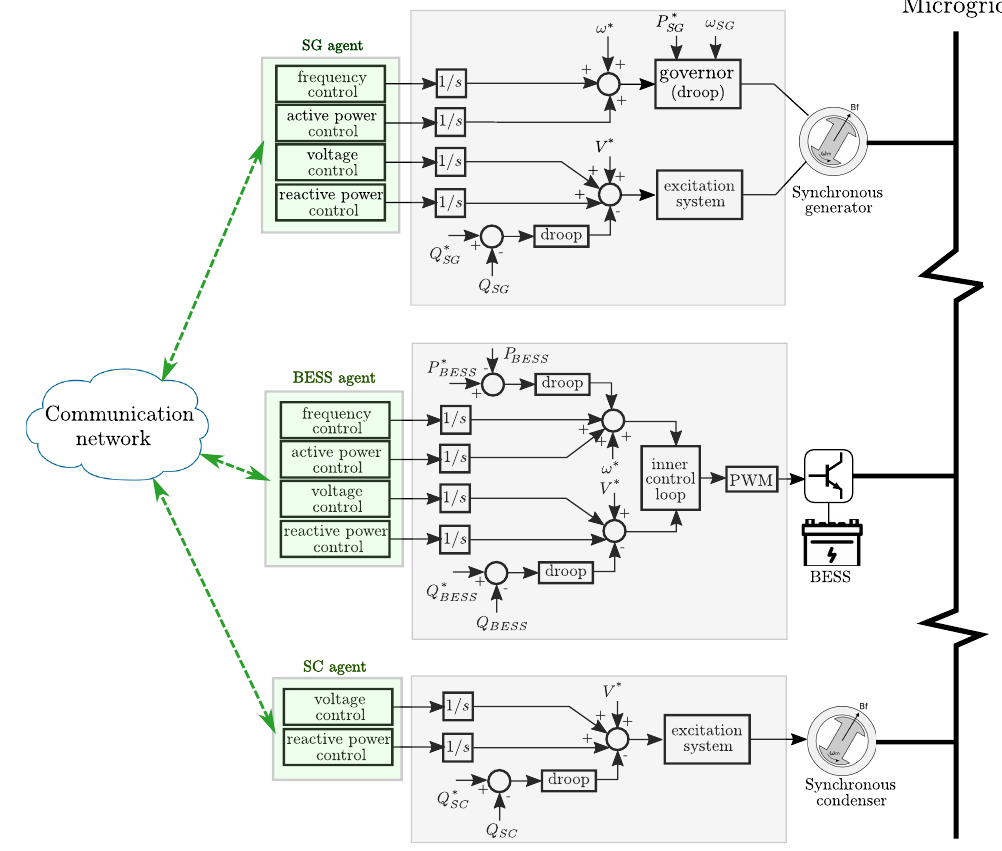
Figure 1. The proposed distributed secondary control framework diagram for